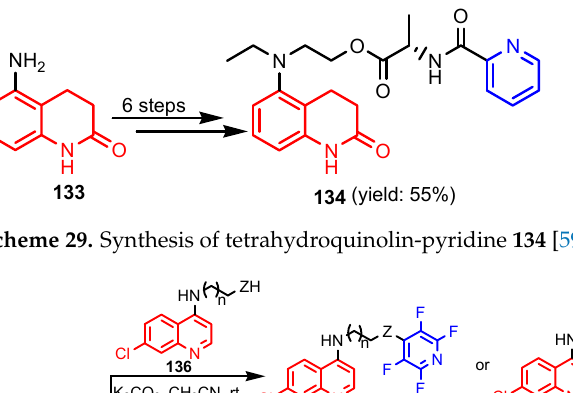
Figure 15. The computational work (molecular docking) for the oxacalixarenes used the Schrodinger software version 9.0 for the molecular docking.